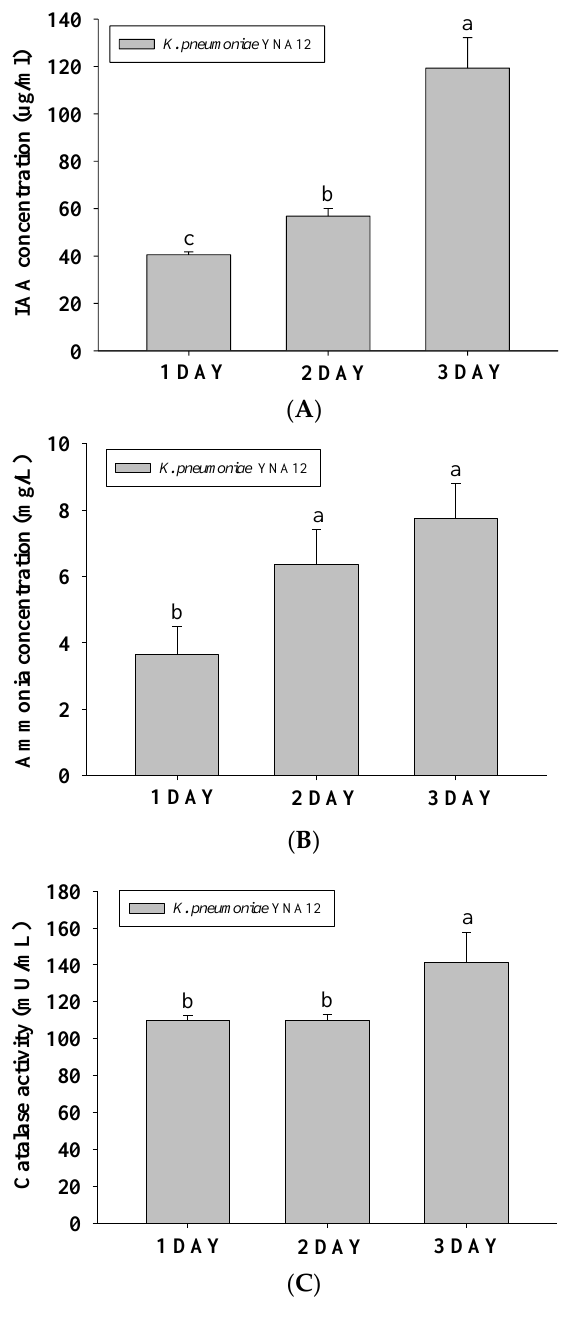
Figure 3. Quantification of indole-3-acetic acid (IAA) ( A ), ammonia ( B ), and catalase ( C ) produced by endophytic YNA12: Values and error bars represent the mean ± standard deviation ( n = 3). Means followed by the same letter (a, b, and c) are not significantly different ( p ≤ 0.05) according to Duncan’s multiple range test.